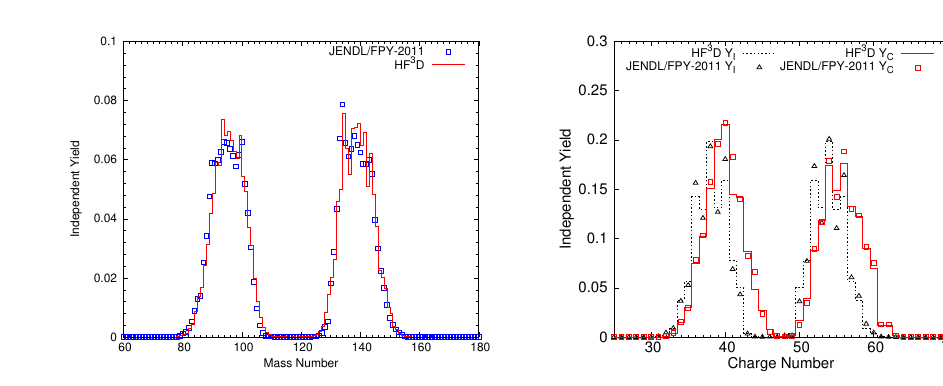
Figure 2. The mass total independent FPY of Figure 3. The charge total independent and cumu- 235 U(n 3 D model and the lative FPY of 235 U(n th ,f) calculated by the HF 3 D th ,f) calculated by the HF evaluated data in JENDL / FPY-2011 model and the evaluated data in JENDL /